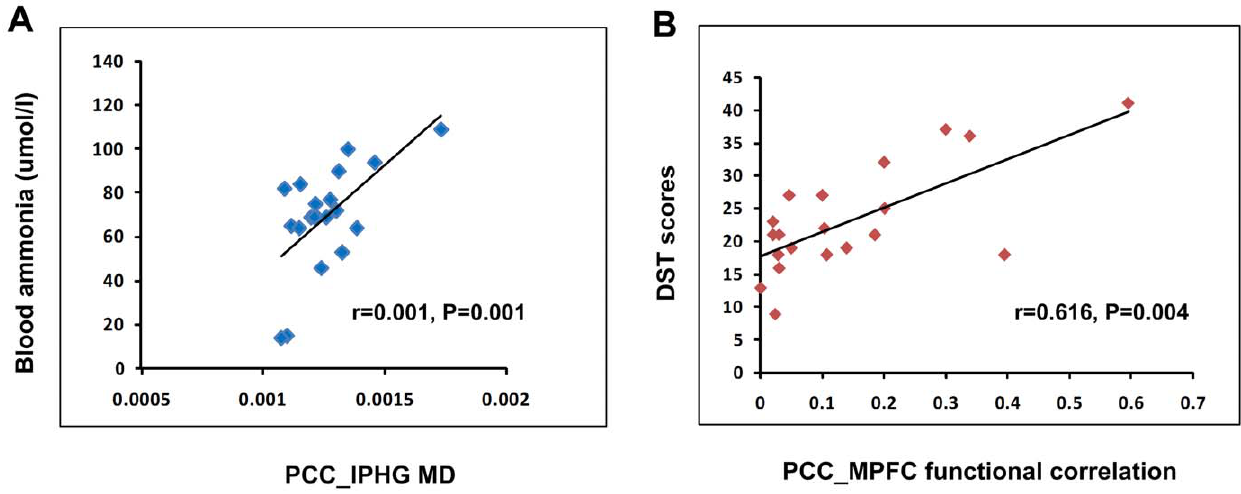
Figure 5. Correlation between the structural/functional indices and clinical markers of MHE patients. Pearson correlation results reveal that in MHE patients, the MD values of the tracts connecting PCC/PCUN to the left PHG positively correlate to the blood ammonia levels, the temporal correlation coefficients between PCC/PCUN and the MPFC show positive correlation to the DST scores ( P , 0.05, Bonferroni corrected). MHE=minimal hepatic encephalopathy; MD=mean diffusivity; PCC/PCUN=posterior cingulate cortex/precuneus; PHG=parahippocampal gyrus; MPFC=medial prefrontal cortex; DST=digital symbol test.